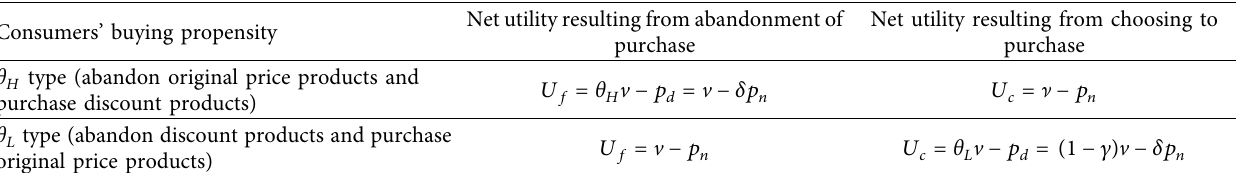
Table 2: Consumer’s net utility